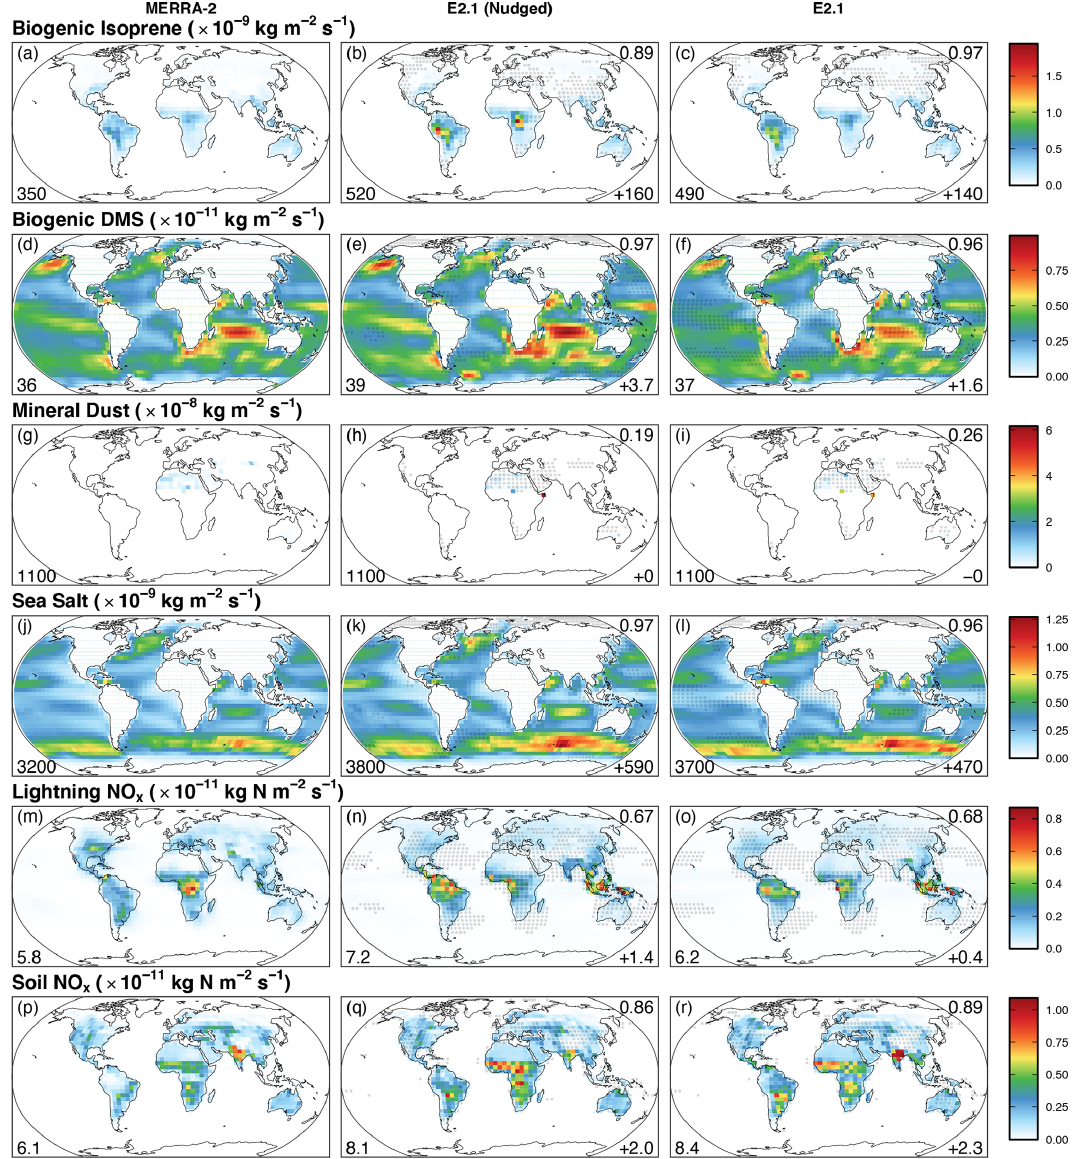
Figure 8. Annual mean spatial distribution of meteorology-dependent emission fluxes for 2005–2014CE. Each column from left to right shows emission fluxes calculated using: MERRA-2 meteorology, E2.1 meteorology nudged to MERRA-2, and the free-running E2.1 meteorology, respectively. Each row from top to bottom shows emission fluxes for: (a–c) isoprene (2-methyl-1,3-butadiene; CH 2 =C(CH 3 )CH=CH 2 ) from terrestrial plants in 10 − 9 kgm − 2 s − 1 , (d–f) dimethylsulfide ((CH 3 ) 2 S; DMS) from marine organisms, (g– i) aeolian mineral dust, (j–l) aeolian sea salt, (m–o) the vertically integrated source of NO from lightning, and (p–r) NO from soil mi- crobial activity, respectively. Gray dots indicate locations where the two E2.1-driven simulations show statistically significant differences ( p value < 0.05; n = 10 years) with respect to the MERRA-2-driven simulation. The value in the lower left of each panel gives the globally integrated source in (a–l) Tgyr − 1 or (m–r) TgNyr − 1 . The number in the lower (upper) right of each panel gives the total difference